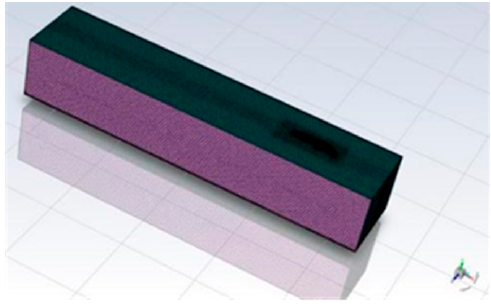
Figure 7. Computational domain and grids.